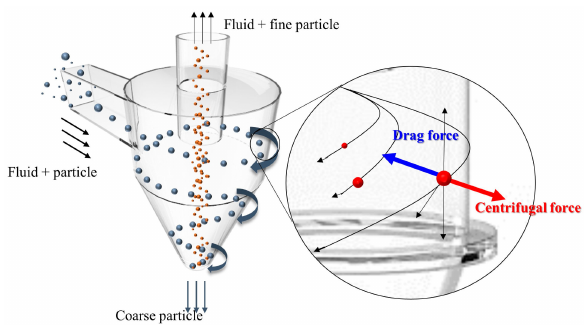
Figure 1. Geometry of the cyclone